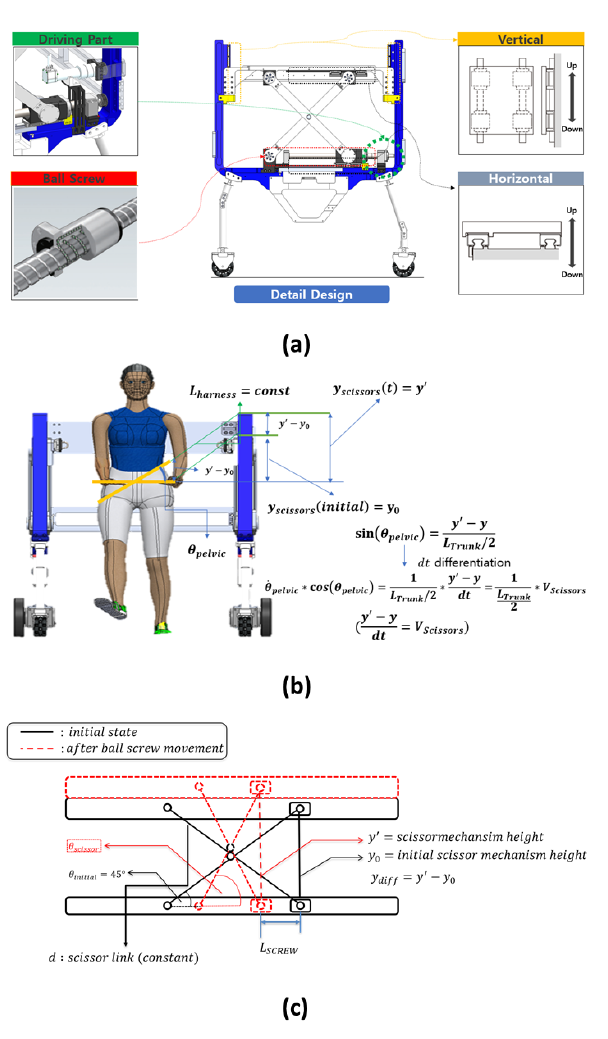
Figure 7. ( a ) The detailed design of the scissor mechanism. The driving part (green and red parts in ( a ) consists of the BLDC motor and ball screw. If the BLDC motor rotates, the ball screw changes the motor rotation to linear motion. Then, the bottom of the scissor mechanism moves in the hor- izontal direction through the LM guide (gray part in ( a ), and the top of the scissor mechanism moves in the vertical direction through the LM guide (yellow part in ( a ). As a result, this vertical movement facilitates the BWS of the patient and pelvic obliquity movement along the frontal plane. ( b , c ) The kinematic model. ( b ) The modeling of the ball screw to the scissor mechanism. ( c ) The scissor mechanism for the human pelvic obliquity